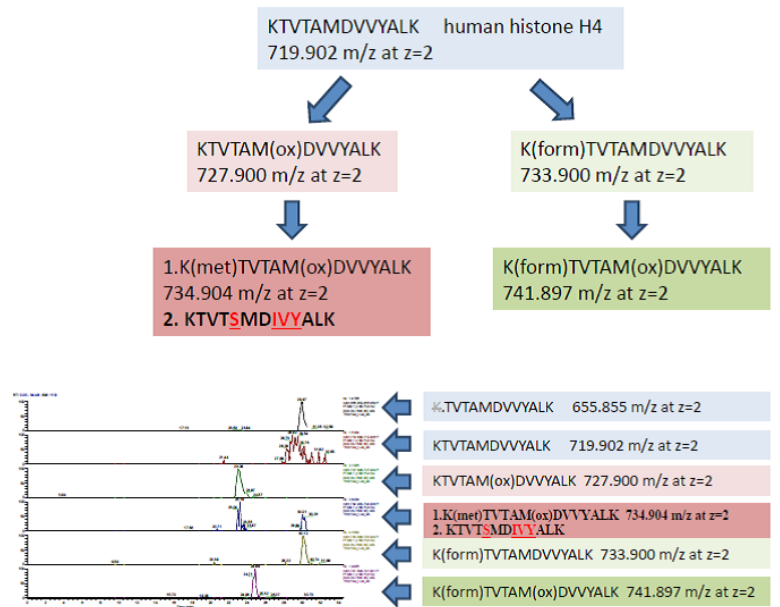
Figure 12. Proteomics data summary. Mass spectrometry identified human conventional and ancestral human H4 histone variants. Direct analyses and narrow scan in mass range 730–740 m/z; MSMS for center mass 734.40 m/z (2 nd isotope of 733.9 m/z; z=2); MSMS for center mass 744.40 m/z (2 nd isotope of 734.9 m/z; z=2) confirmed the co-existence of the human and ancestral H4 isoforms (with the IVY pattern) at 734.905 m/z;